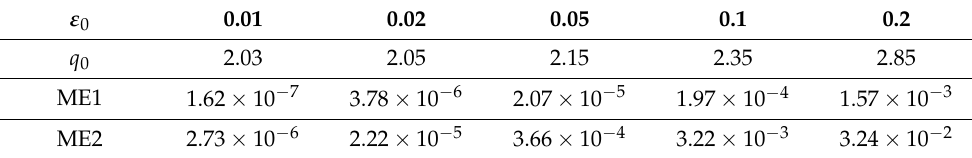
Table 2. The maximum error (ME) for the analytic solution of Example 2 with different ε 0 . ε 0